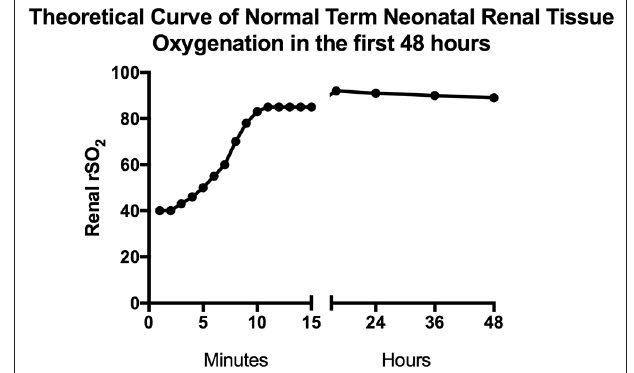
FIGURE 2 | Estimated normal term neonatal renal tissue oxygenation in the first 48h. This figure depicts predicted normal values of renal tissue oxygenation in term babies during the first 48h of life based on studies done by Montaldo and Bailey (16, 17). The first 15min of data are mean values from the Montaldo et al. study and the remaining data are median values from the Bailey et al.